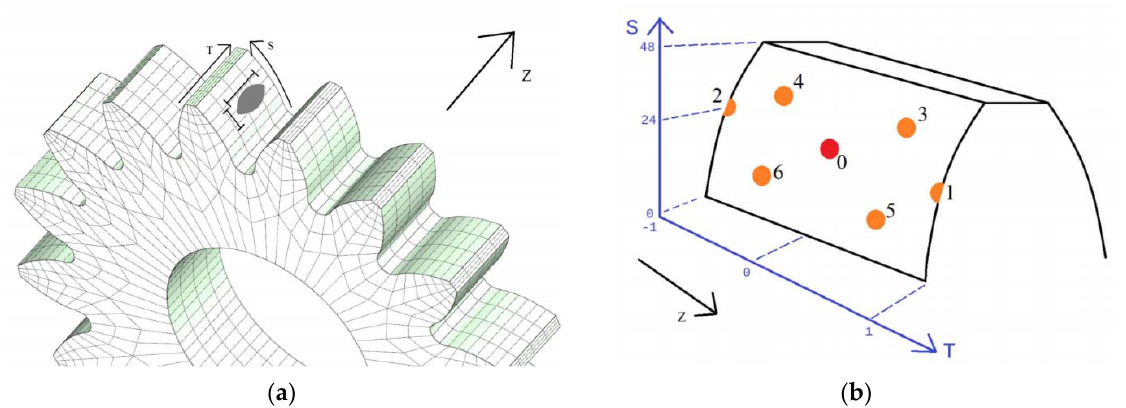
Figure 7. ( a ) Representation of a pit on the face of a tooth; ( b ) position indexes. S is the radial reference axis and T is the axial one.